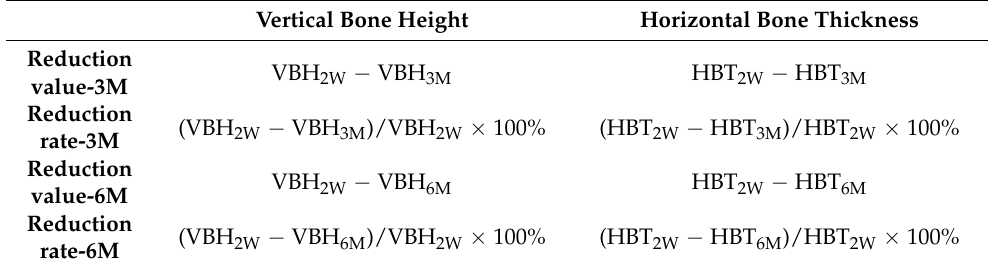
Table 3. Analysis formulas.